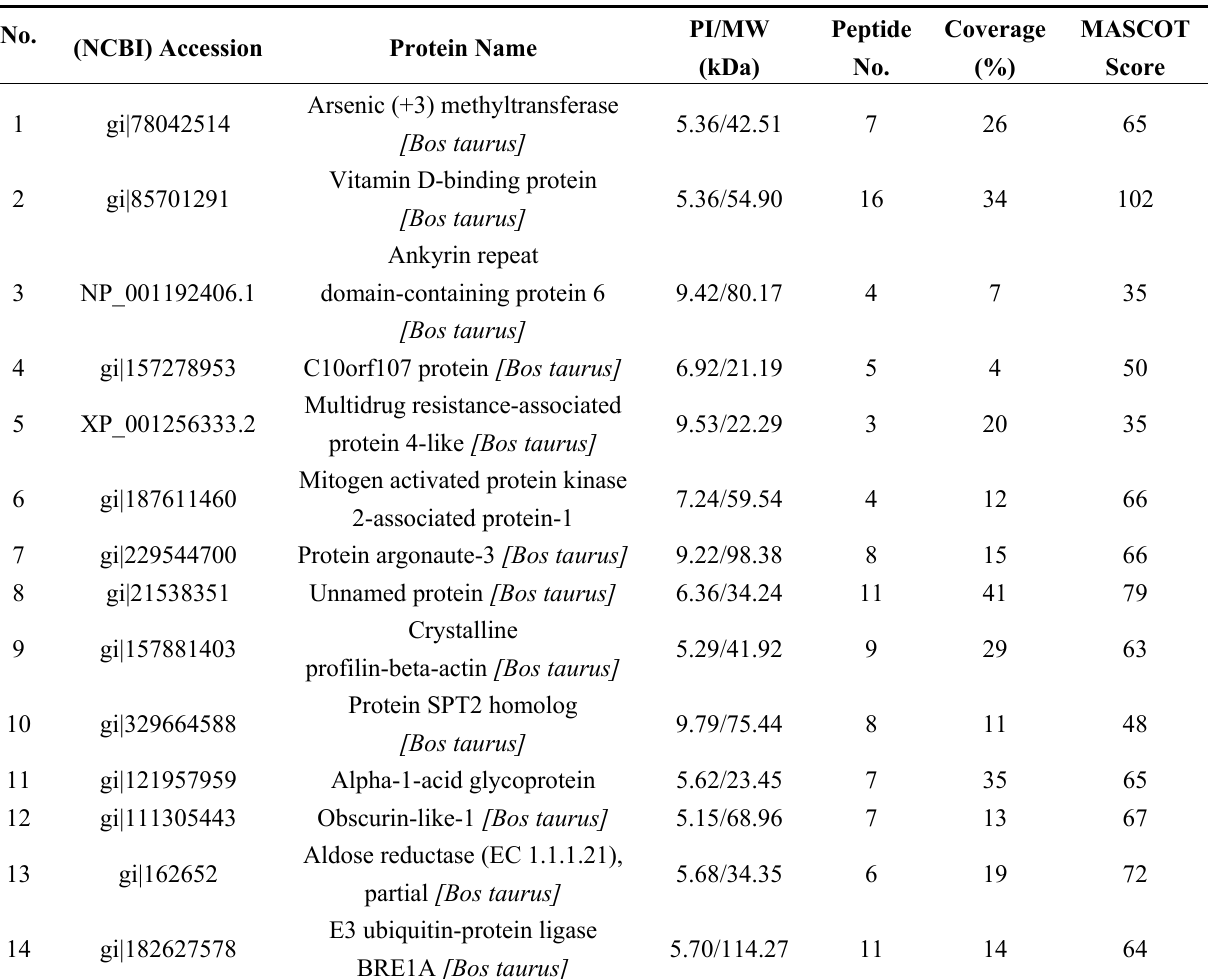
Table 1. Matrix-assisted laser desorption/ionization time of flight mass spectrometry (MALDI-TOF/TOF-MS) identification of differentially expressed proteins in the follicular fluid of Tianzhu white